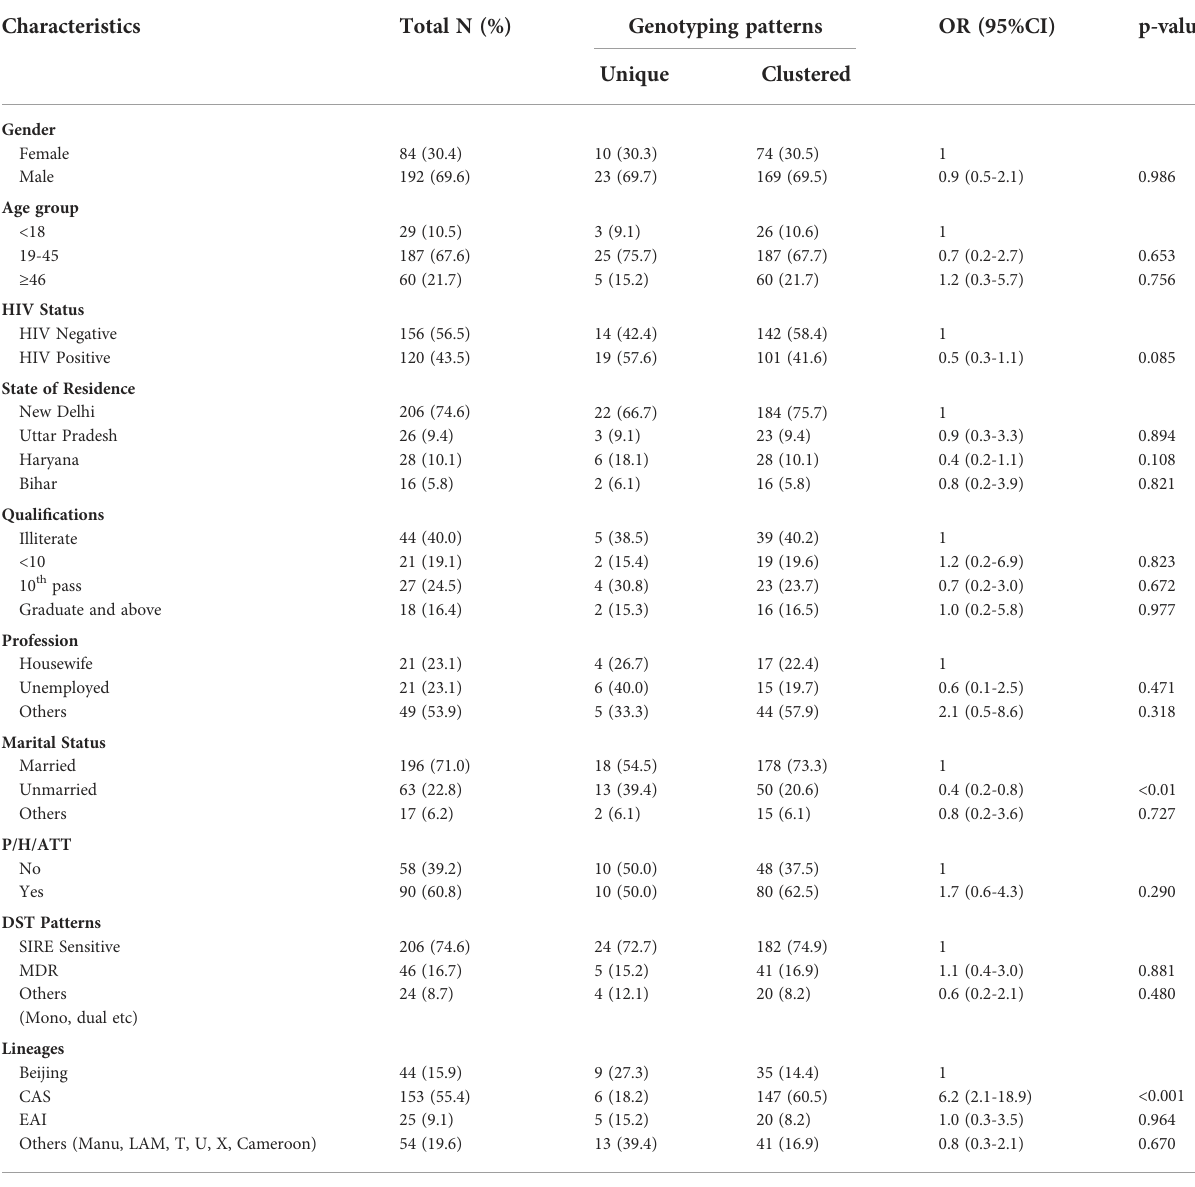
TABLE 6 Co-relation of various demographical and other factors between Clustered and Unique MTB